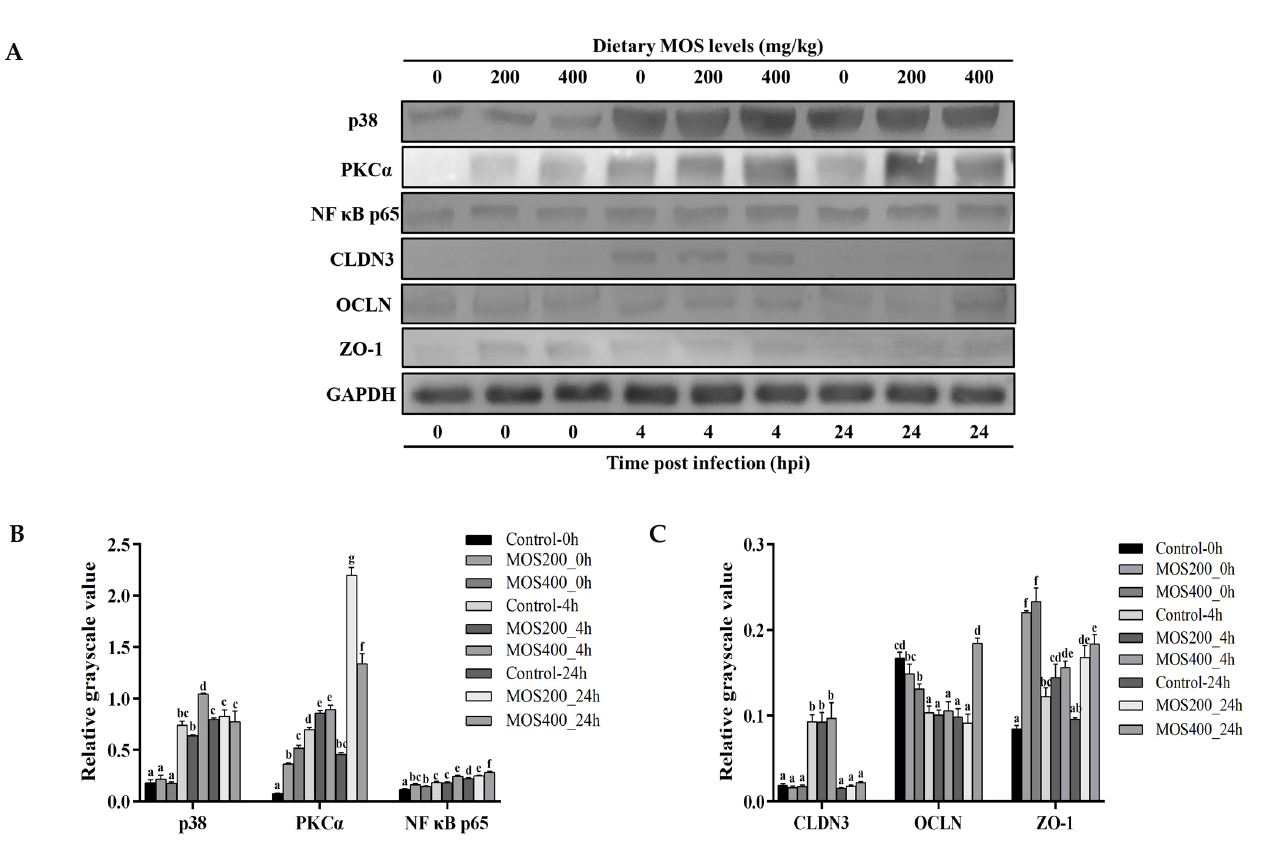
Figure 9. The expression of partial tight junction-related proteins and transcriptional regulators in the intestines of M. amblycephala was analyzed by western blot. ( A ) Western blot analyzed the expression of partial tight junction-related proteins and transcriptional regulators. The relative expression of tight junction-related proteins ( B ) and transcriptional regulators ( C ) was calculated by the gray value of the western blot. Different alphabets indicate statistically significant differences after performing Tukey’s HSD test ( p < 0.05).